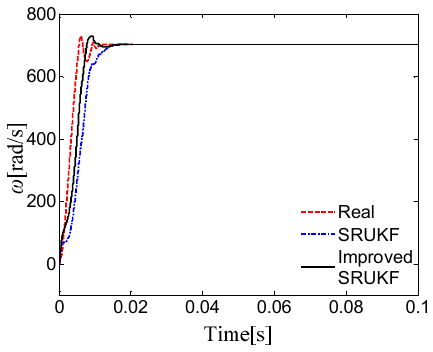
Figure 14. Speed estimation at parameters disturbance.